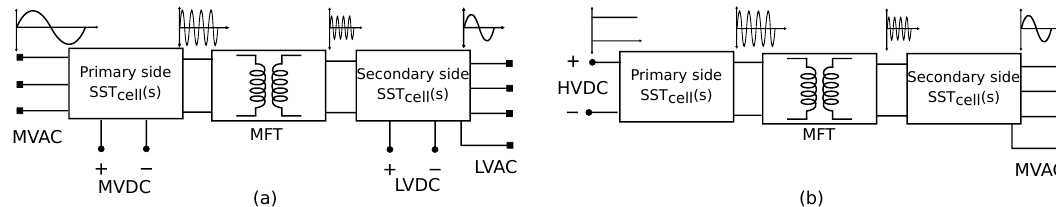
Figure 13. Classification of SST based on voltage levels: ( a ) MV/LV configuration [48,49]; ( b ) HV/MV configuration [59,60].